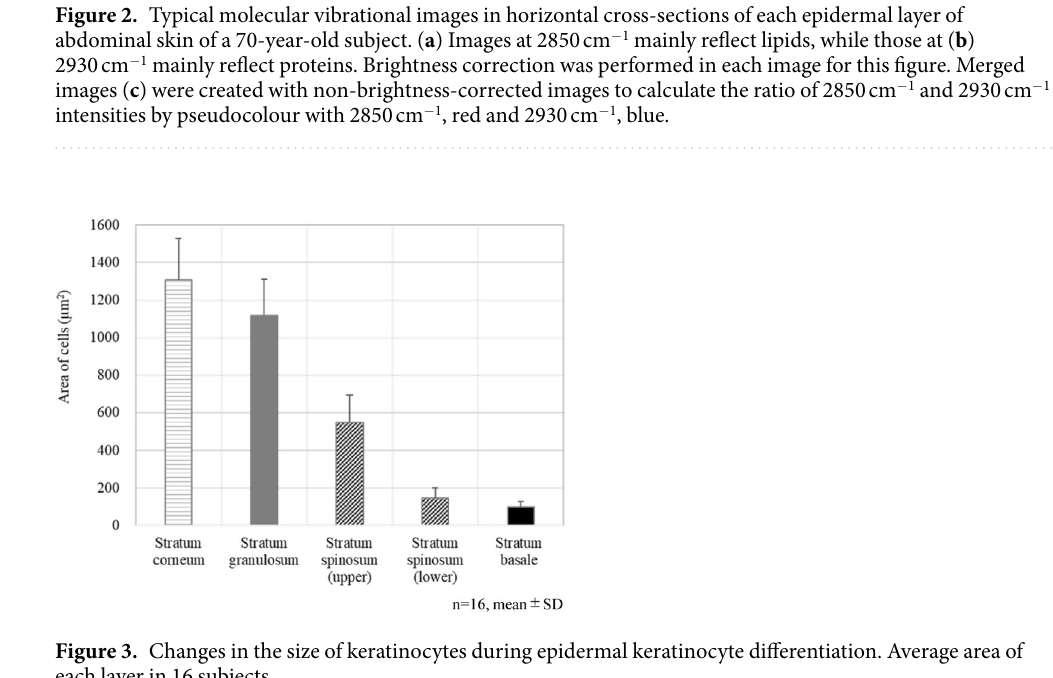
Ambiguous cell outlines in the Sc as a result of aging. Figure 7 shows typical horizontal cross-section images of the SC at 2850 cm − 1 (reflecting mainly lipids) and 2930 cm − 1 (reflecting mainly proteins) in skin of dif- ferent ages. Cell outlines were unclear in aged skin but were clear in skin from younger individuals. Differences in the vulnerability of the cell membrane or abnormally formed intercellular lipids are potential reasons underlying this observation.